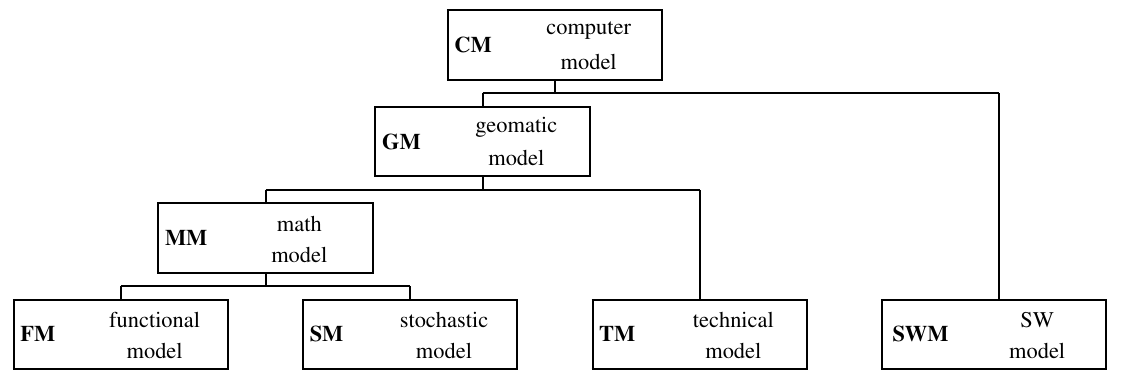
Figure 2: A modeling hierarchy in a network software